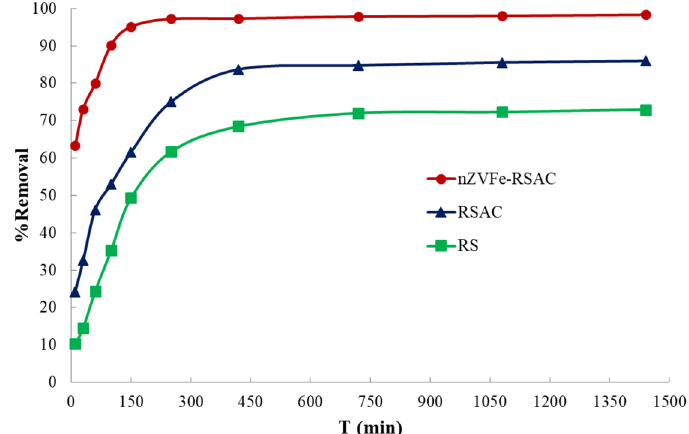
Figure 7. Effect of the exposure time on the Pb(II) adsorption by RS, RSAC, and nZVFe–RSAC (C 0 = 100 mg L − 1 ; T = 25 °C).